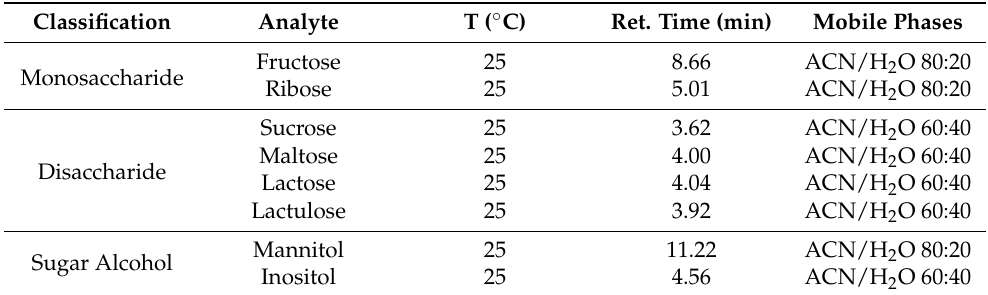
Table 1. Chromatographic data of sugars’ separation performed on the VSG_HD-1-Photo-Cys.